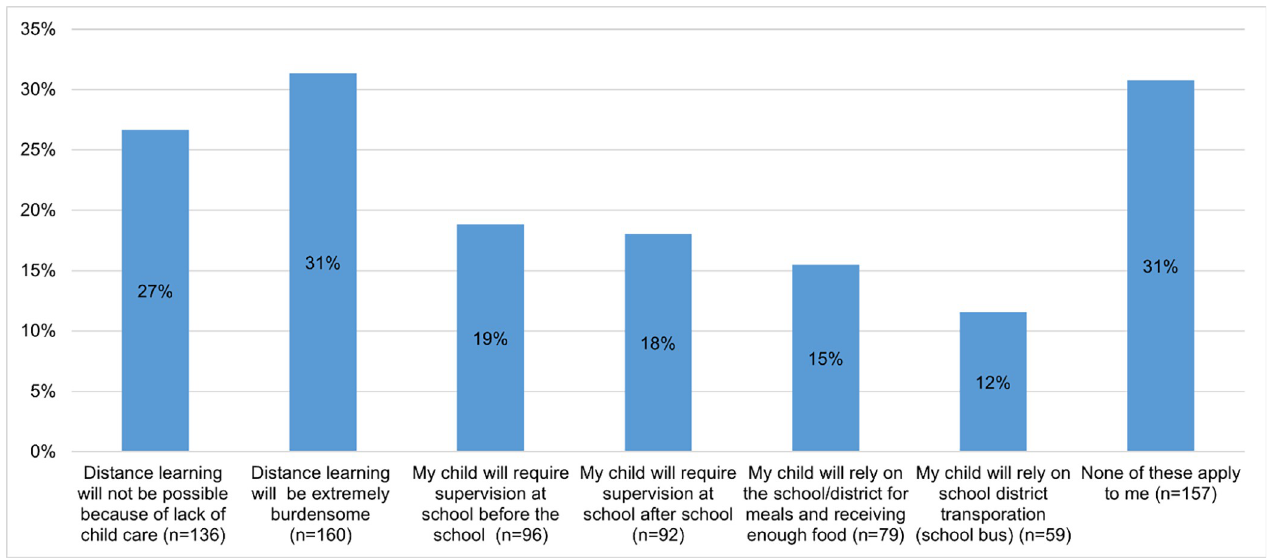
Fig 1. Challenges parents anticipate facing during the 2020–2021 school year. Note: Cumulative percentage could be greater than 100% because respondents were allowed to select multiple options in responding to this question about challenges they anticipated during the 2020–2021 school year.